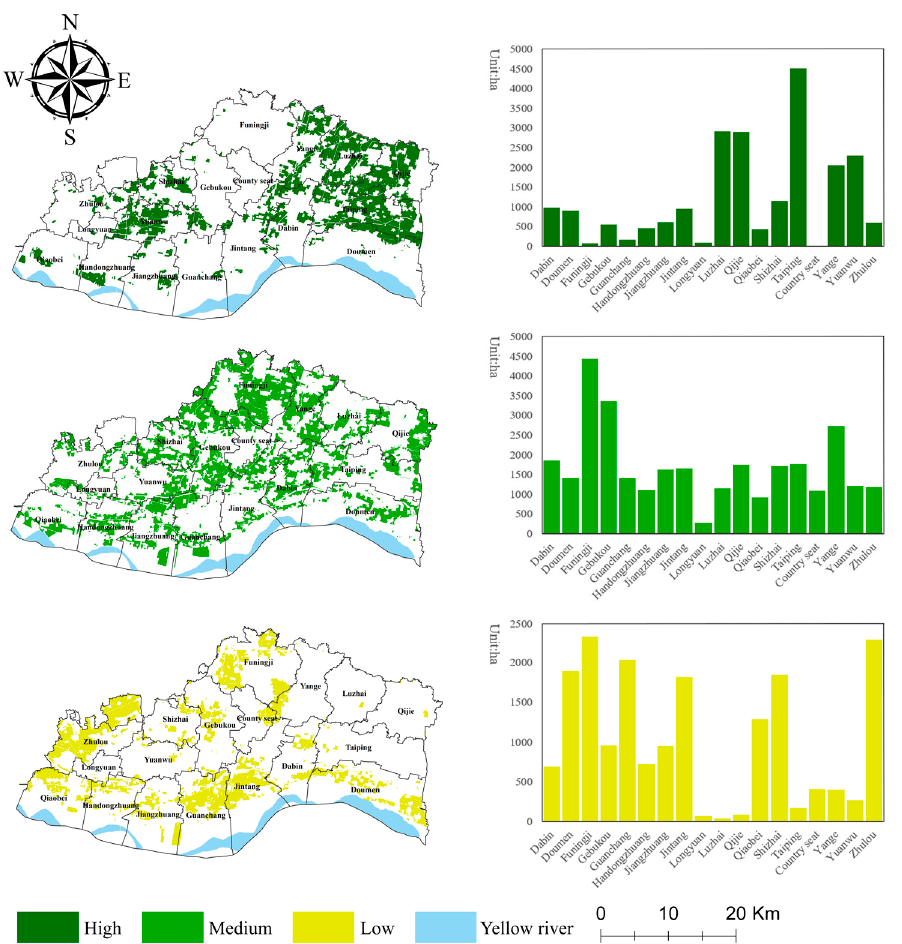
Figure 3. Spatial distribution of the ecological security level of cultivated land in Yuanyang County.